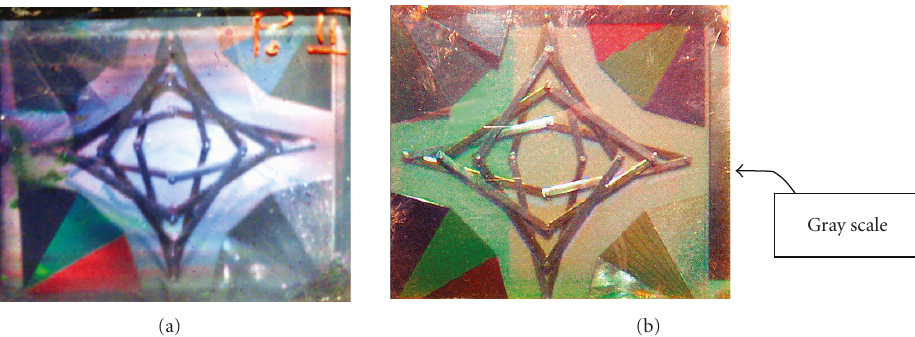
Figure 7: Reconstructed images of a test object from a single layer (a) and two layers (b) reflection holograms recorded on ultrafine grain light sensitive material